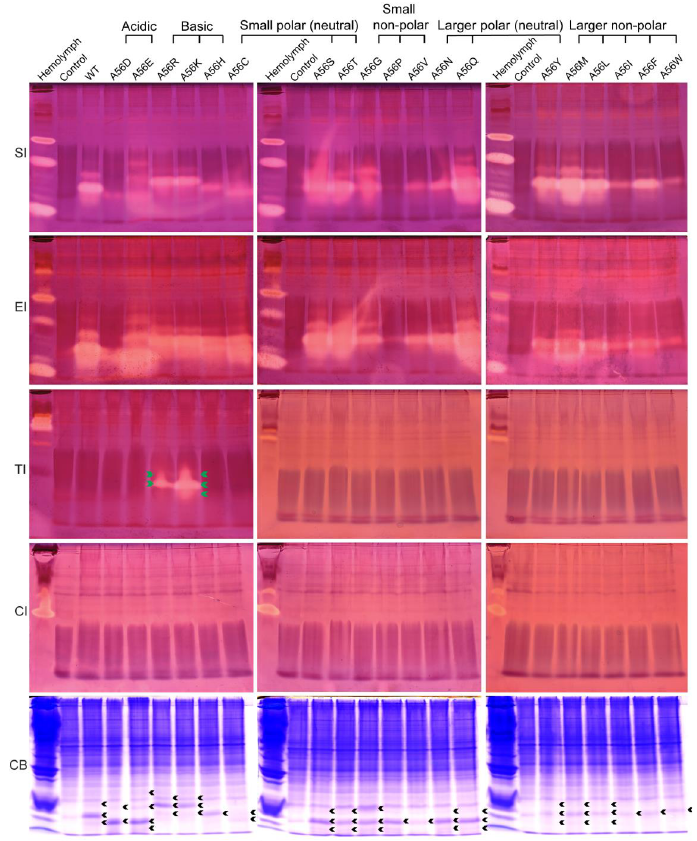
Figure 4. Activity staining of the P1 mutants of BmSPI39 against the serine protease. B. mori hemolymph from day 5 fifth-instar larvae was used as positive control. “Control” represents the lysate supernatant of Origami 2(DE3) cells transformed with the p28 plasmid. “WT” represents the wild-type recombinant BmSPI39 protein. “SI”, “EI”, “TI” and “CI” indicate inhibitory activity against subtilisin, elastase, trypsin, and chymotrypsin, respectively. “CB” indicates protein staining with Coomassie Brilliant Blue R250. Green arrows indicate the inhibitory-active bands of the P1 mutants against trypsin, and black arrows indicate the Coomassie Brilliant Blue-stained protein bands at the position corresponding to the inhibitory-active